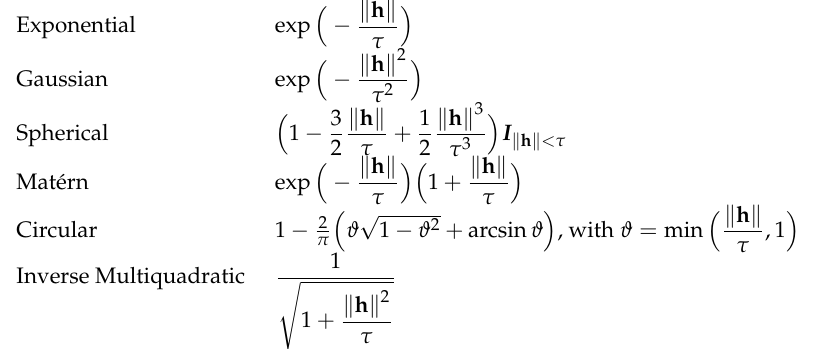
Table 1. Covariance functions φ τ ( h ) used in the generalized geoadditive model (1).